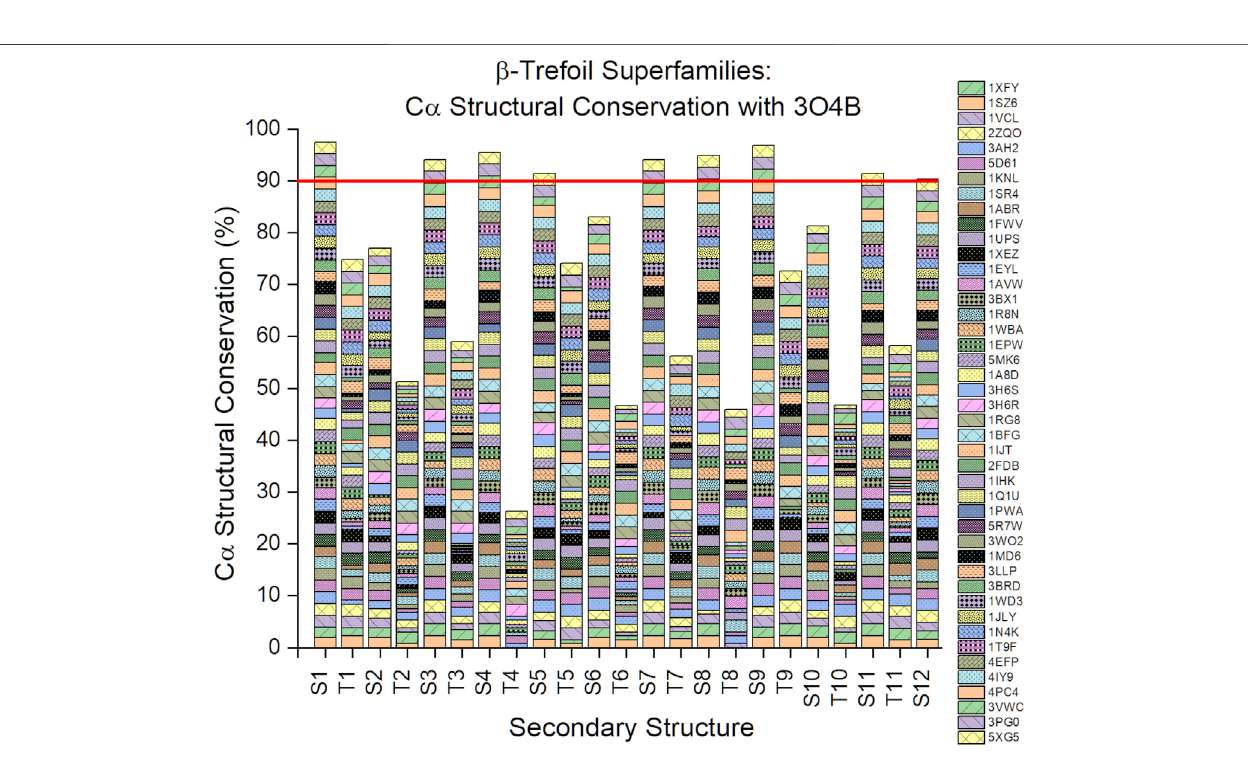
Frontiers in Molecular Biosciences |